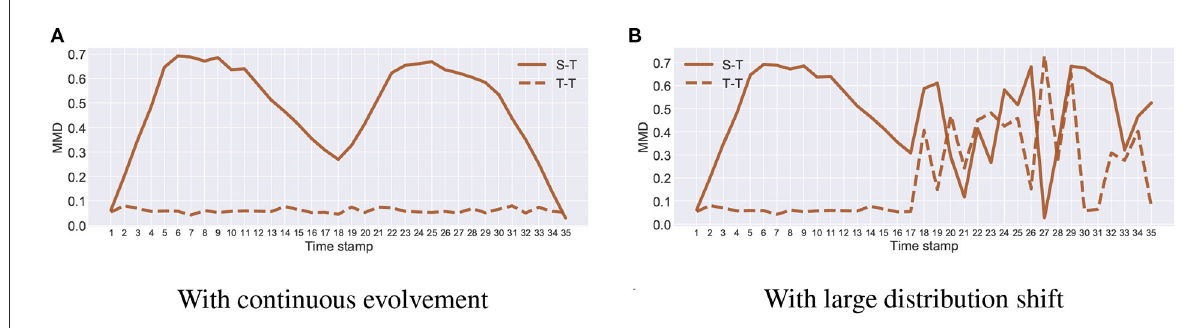
FIGURE3 Rotating MNIST with (A) continuous evolvement and (B) large distribution shift.